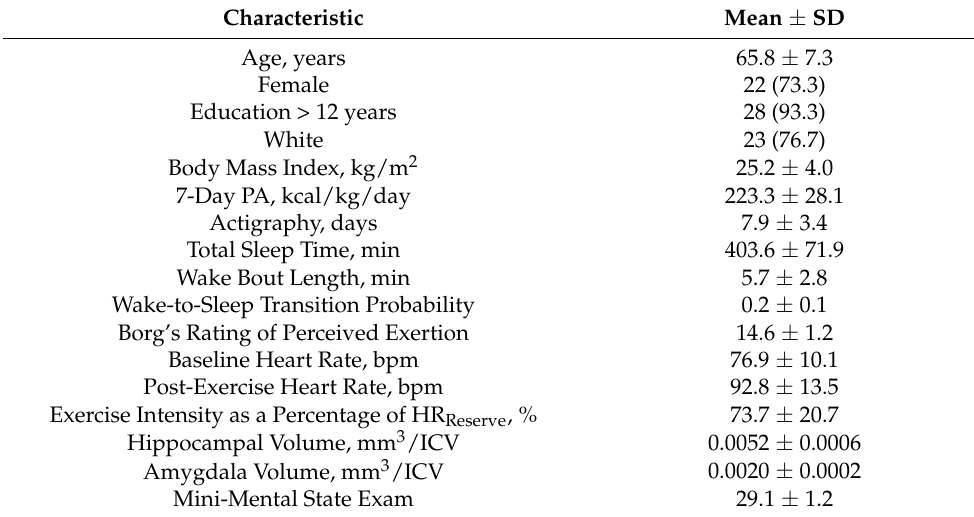
Table 1. Participant